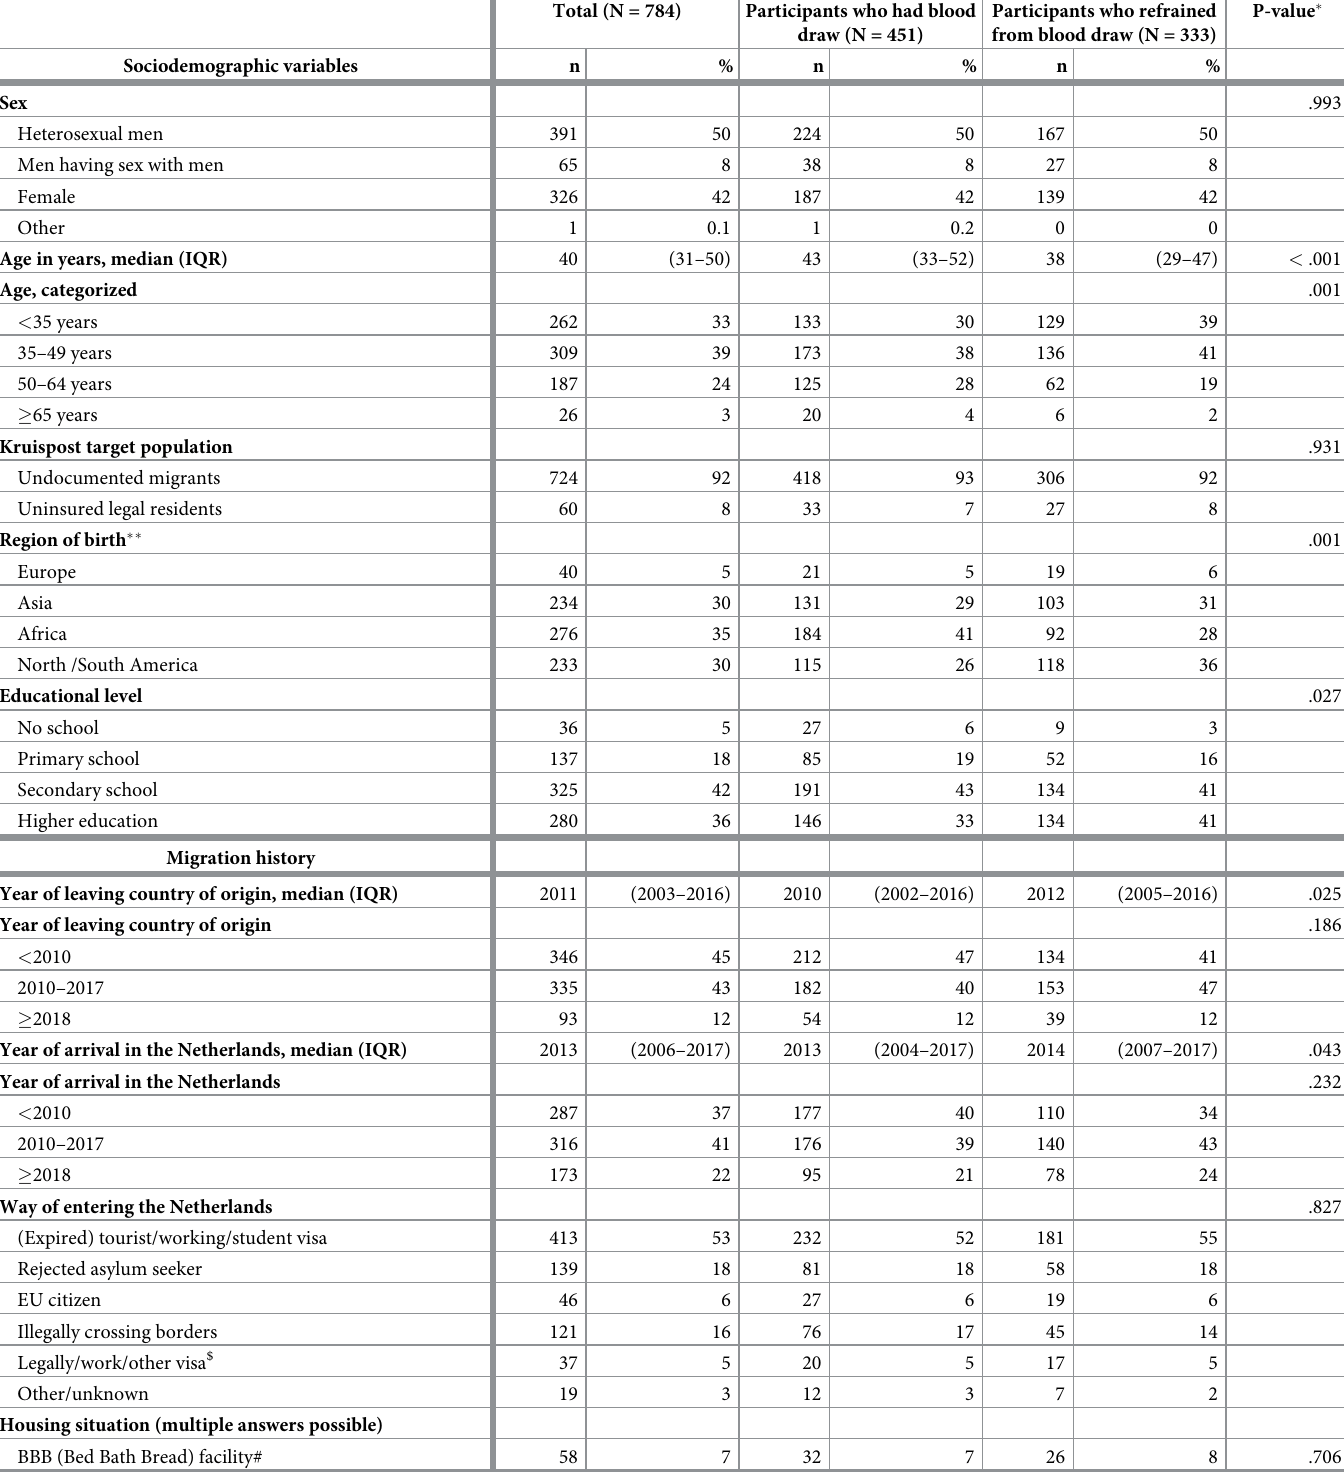
Table 1. Characteristics of undocumented migrants and uninsured legal residents (N = 784) who participated in the Kruispost study to screen for HBV, HCV and HIV, in Amsterdam, the Netherlands, October 2018- October